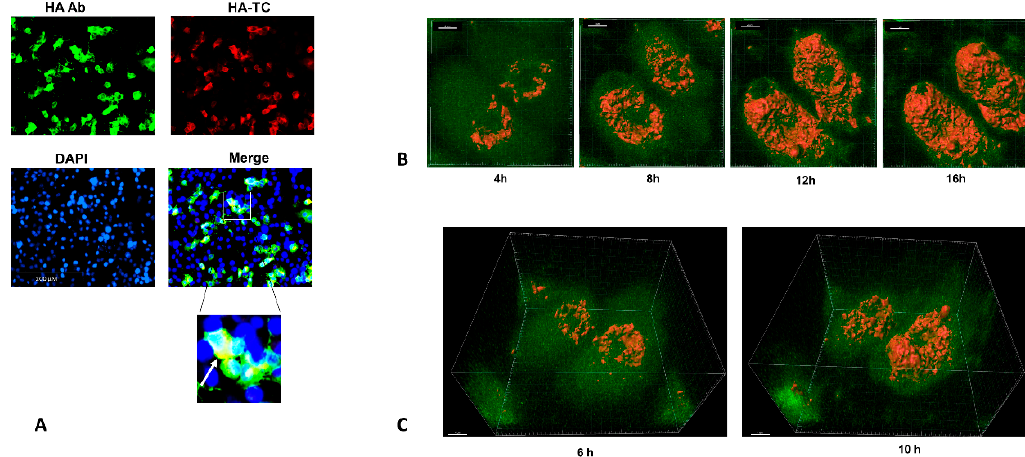
Figure 3. Live 4D imaging of HA in cells infected with HA-TC reporter IAV: ( A ) MDCK cells were infected with HA-TC PR8 at MOI of 1. On 12 h post infection, cells were subjected to immunostaining with anti-HA primary and alexa-488 (green) secondary. Subsequently cells were stained with ReAsh dye as per the manufacturer’s instruction. Finally, fixed cells were observed under fluorescence microscope at 40 × objective. The inset shows colocalization between green (anti-HA antibody) and red (ReAsh dye) staining, marked by white arrow. ( B ) MDCK cells were infected with HA-TC PR8 at MOI of 5. On 3 h post infection, HA staining was performed using FIAsh dye as described in Methods. Live imaging was performed using confocal microscope. Z stacks were recorded at 10-min interval starting from 3 h up to 16 h post infection. Imaging data was analyzed and converted to a video using Imaris software. The Figure shows snapshots at indicated time points from the live imaging video (Video S1). HA signal above background was rendered in 3 dimensions given orange color using Imaris software. ( C ) Shows 3D perspective of HA staining from the top of the cells at indicated time points post infection. This was generated by integrating Z stack of confocal images and processing it into a 3D movie using Imaris software (Video 2).